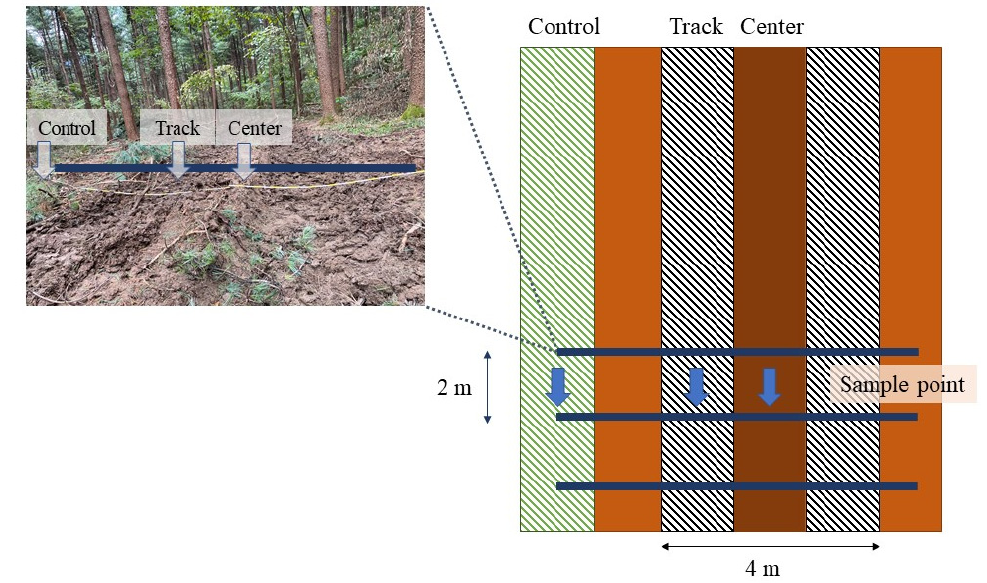
Figure 2. Sample points (control, track, and center) along the harvester and forwarder trails. In addition to the soil parameters, soil displacement was measured by a ruler using a cross-sectional measurement method. The bulge and indented areas of the rut were ob- served every 10 cm after the harvester or forwarder passes. A comparable method of soil displacement was reported by Poltorak et al. [14] and Cambi et al. [33]. All measurements were completed one week post-thinning.